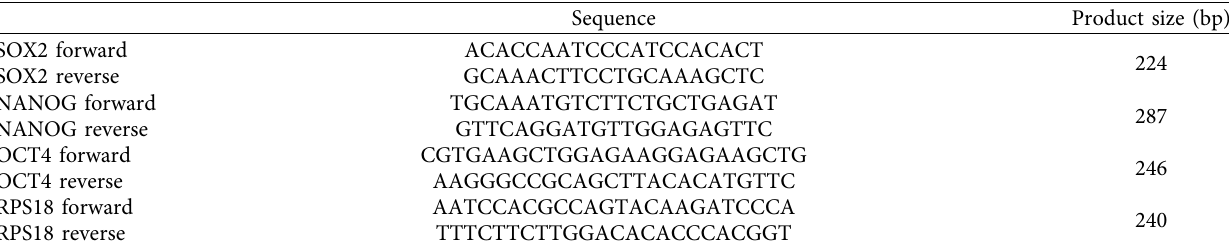
Table 2: Primer sequences and expected PCR product sizes.